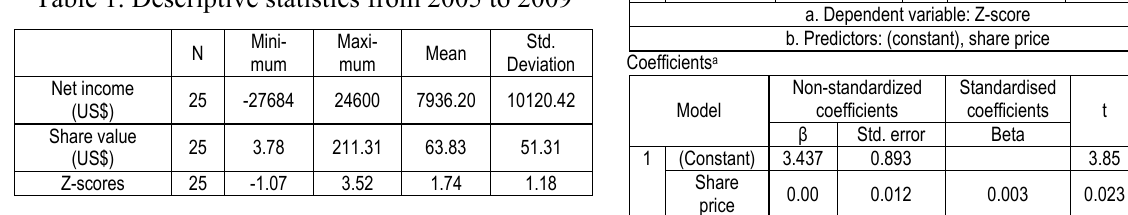
Table 1. Descriptive statistics from 2005 to 2009